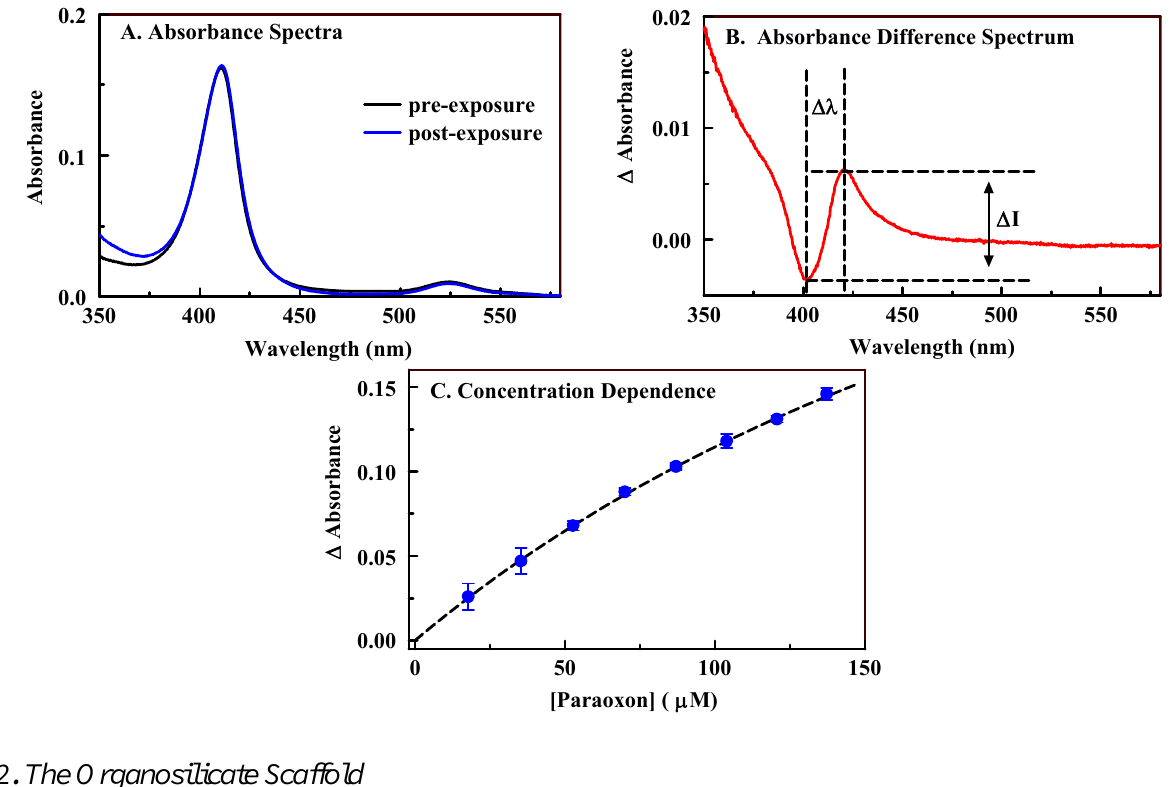
Figure 3. Changes in the porphyrin absorbance characteristics upon interaction with paraoxon. Panel A, absorbance spectra of Ni(II) C S TPP (20 μ M) in the absence and 1 3 presence of paraoxon (100 ppm) in 10 mM PBS. Panel B, difference spectrum calculated as post-exposure minus pre-exposure absorbance. In this spectrum, the distance between the peak position and the trough position is ∆λ while the difference between the peak height and the trough depth is ∆ I. Panel C, concentration dependence of the interaction TPP (4 μ between paraoxon and Cu(II) C 4